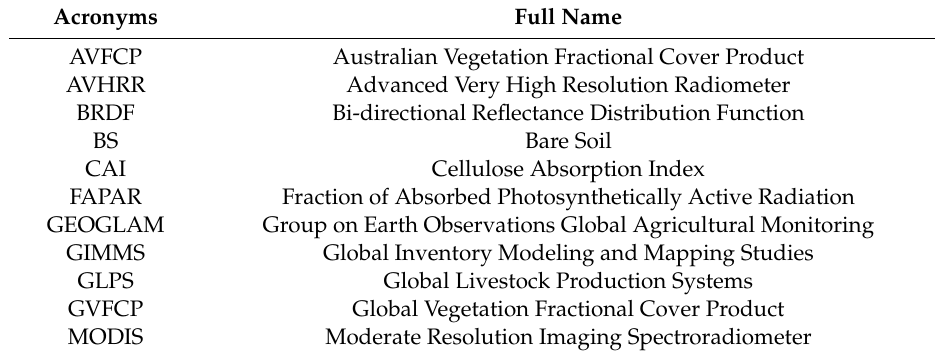
Table A1. Acronyms and abbreviations used (in addition to WGT acronyms documented in Tables A2 and